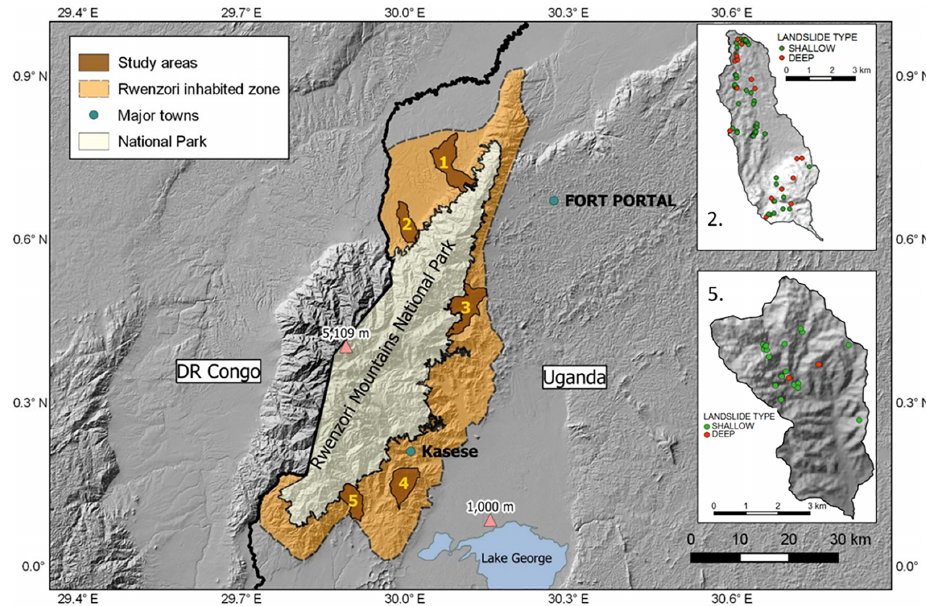
Figure 1. Overview of the surveyed study areas on the Rwenzori foot slopes. The study areas are numbered from north to south: (1) Bundibu- gyo, (2) Nyahuka, (3) Kabonero, (4) Mahango and (5) Kyondo. For Nyahuka (2) and Kyondo (5) a detailed map is provided showing the locations of shallow and deep-seated slides. Landslide maps of other study areas can be found in Jacobs et al. (2016b). Table 1. Overview of surveyed study areas (Fig. 1), their surface area and number of total, shallow (SLS) and deep-seated landslides (DSLS) mapped together with the prevailing lithologies in those study areas according to the GTK consortium (2012) and the average annual precipitation as simulated by Thiery et al.